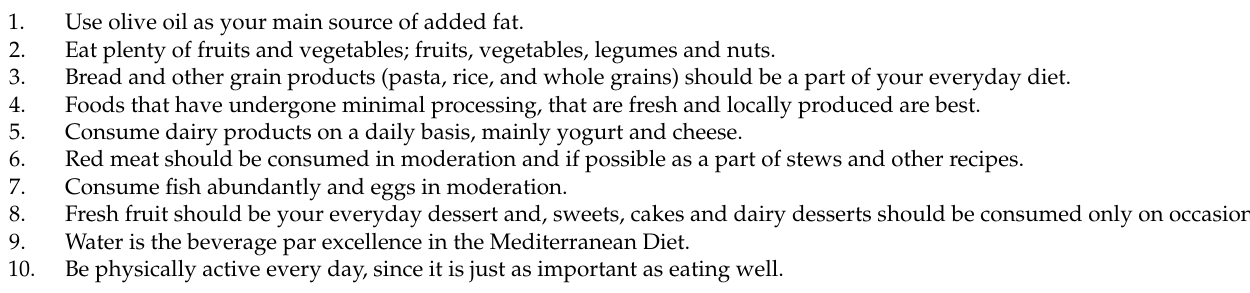
Table 2. Mediterranean diet: 10 basic recommendations.